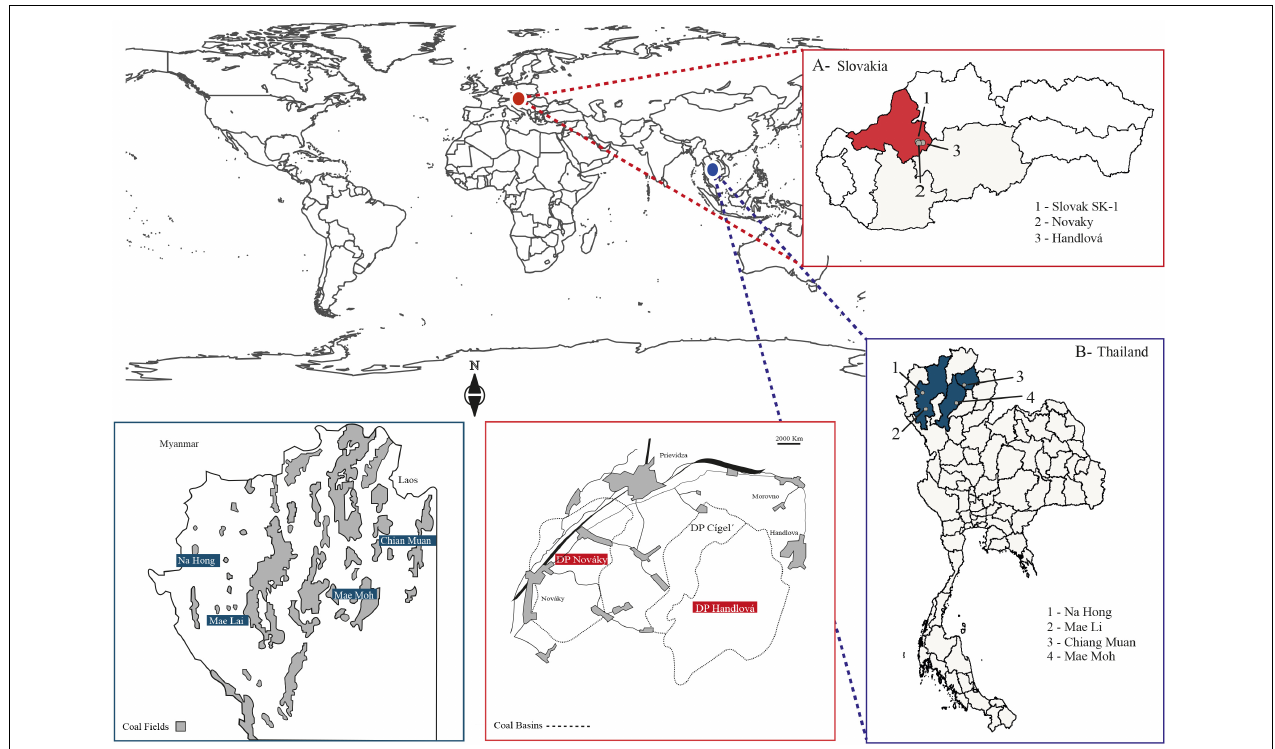
FIGURE 1 | Maps of study areas indicate the regions in Slovakia (red) and Thailand (blue) where the coalfields are located. The gray points indicate the coal basins where the samples for this study were extracted. The regional maps indicating the coal fields and coal basins from Thailand and Slovakia were redrawn and modified from Machajová et al. (2000) and Ratanasthien